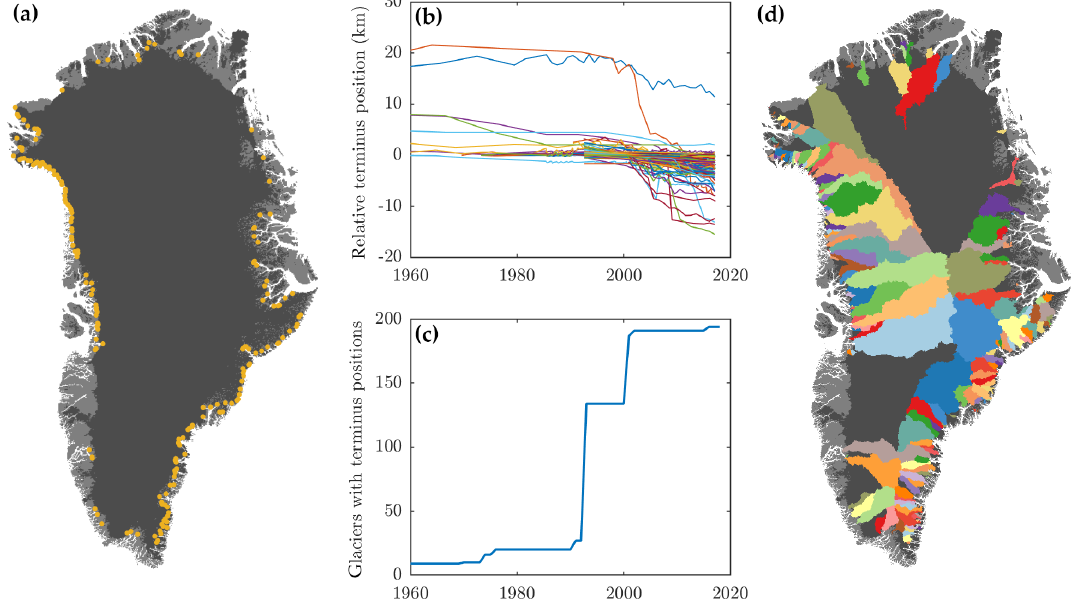
Figure 2. (a) Locations of tidewater glaciers considered, (b) overview of terminus position change at all glaciers, (c) number of glaciers in the dataset as a function of time and (d) hydrological drainage basins for each of the 191 tidewater glaciers in the terminus position dataset, calculated using hydrological flow routing with topography from BedMachine version 3 (Morlighem et al.,